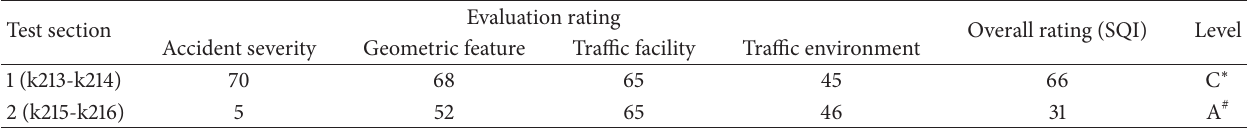
Table 17: Evaluation results of Hebei provincial highway S241